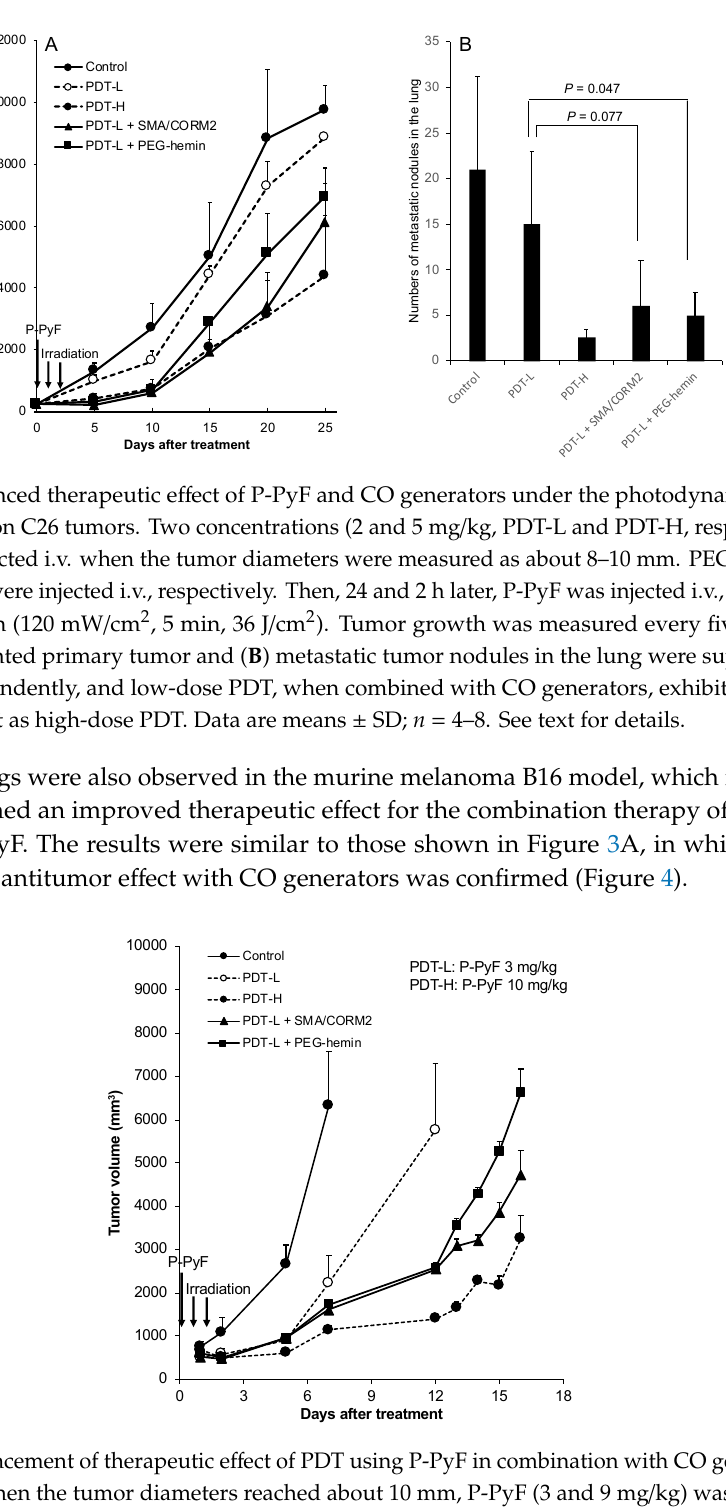
Figure 5. Augmentation of therapeutic effect of P-THP by SMA/CORM2 against C26 ( A ) and S180 ( B ) solid tumors. P-THP was injected i.v. only once at 5 mg/kg. SMA/CORM2 was applied 2 h before the P-THP injection. Inset of ( A ) showed the numbers of metastatic nodules in the lung. Data are means ± SD, n = 4–6. See text for details.